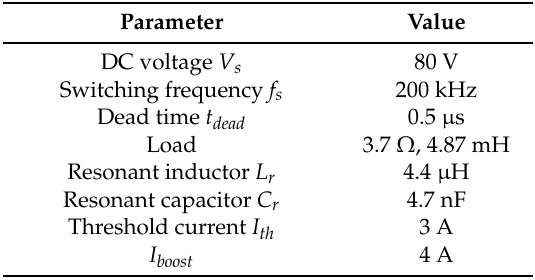
Figure 7. The average voltage error vs. output current with conventional variable-timing control. Table 4. The parameters of the